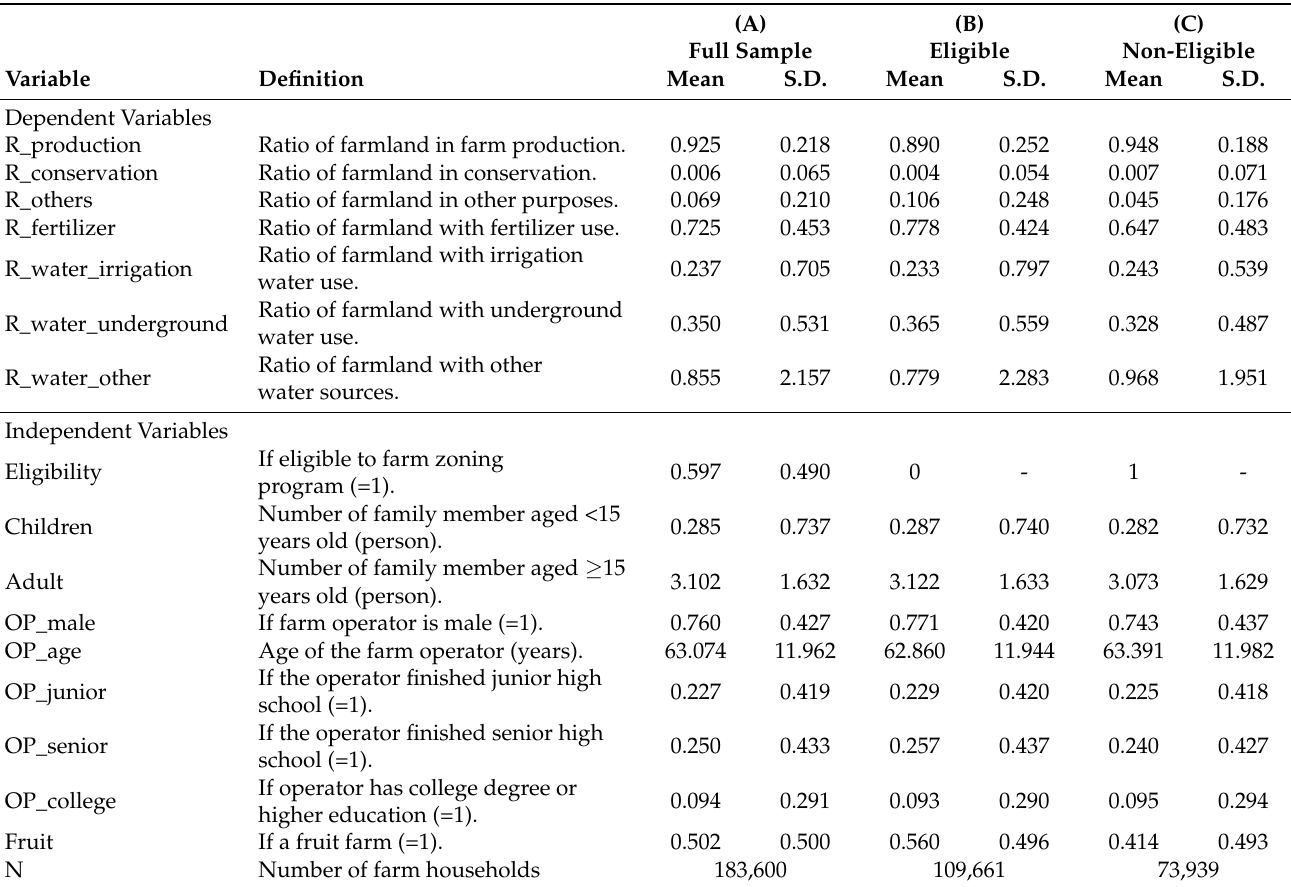
Table 1. Sample Statistics of the Selected